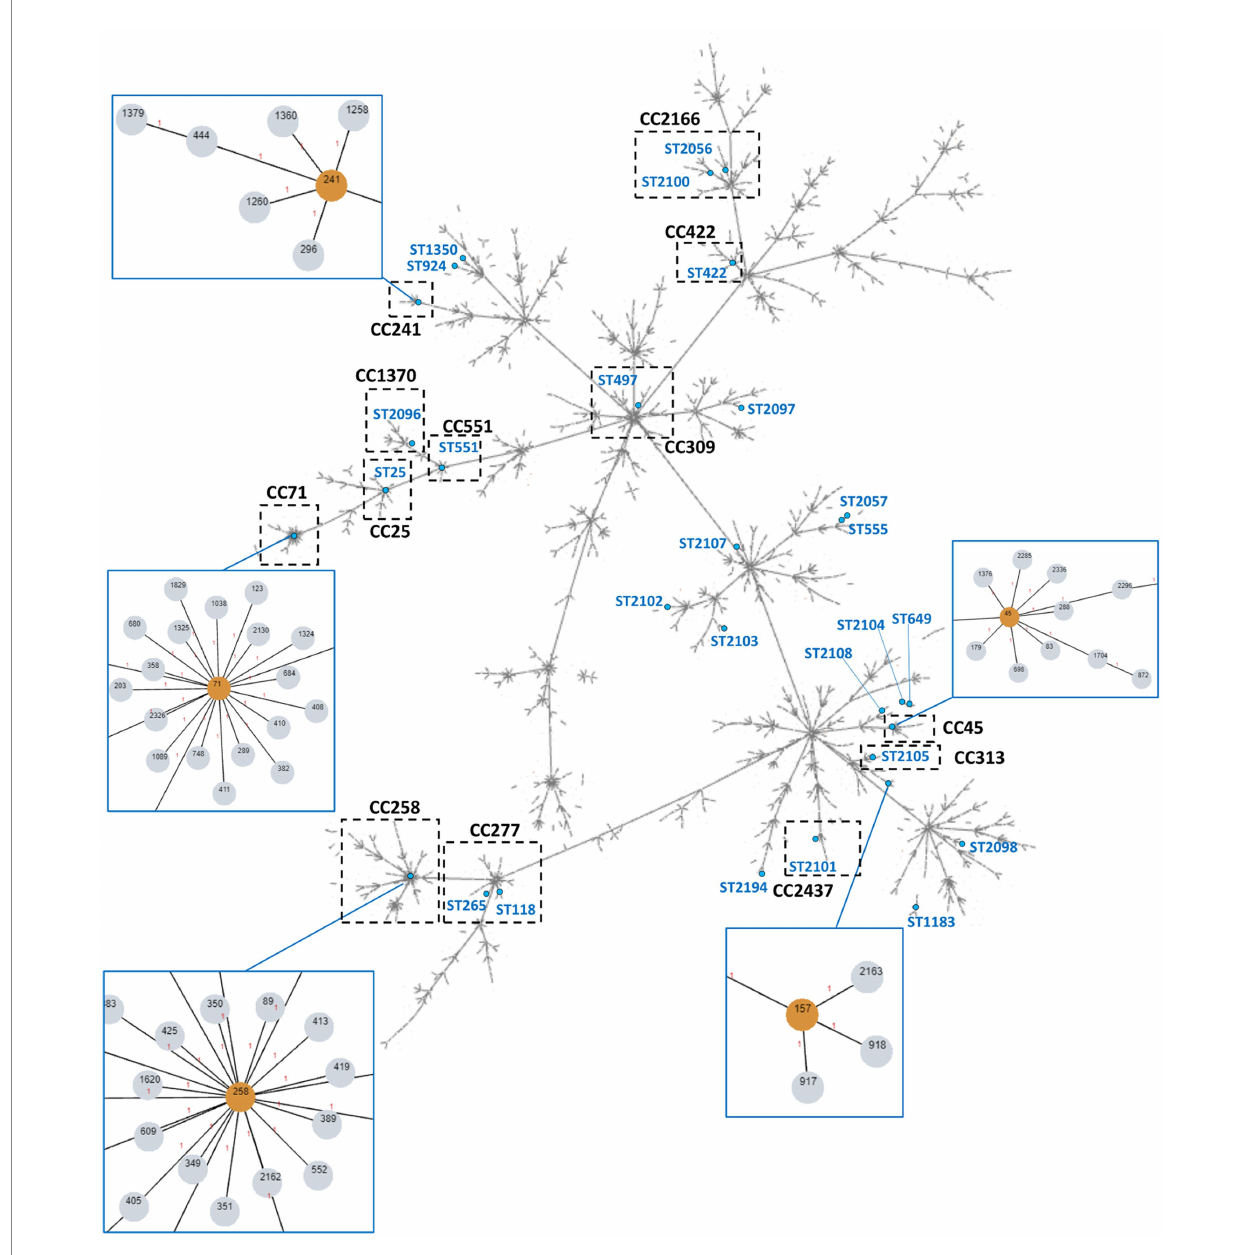
FIGURE 4 Overview of the global S. pseudintermedius population clonal structure. The tree was built using PHYLOViZ online with all S. pseudintermedius STs described in PubMLST database until November 2022, linking all SLVs. The STs found in the collection in study are highlighted in blue lettering or singled out in orange within the blue boxes. The assigned clonal complexes are indicated in bold-type lettering. Dashed boxes highlight CCs containing STs identified in this work. Some of these CCs are zoomed in blue boxes for higher